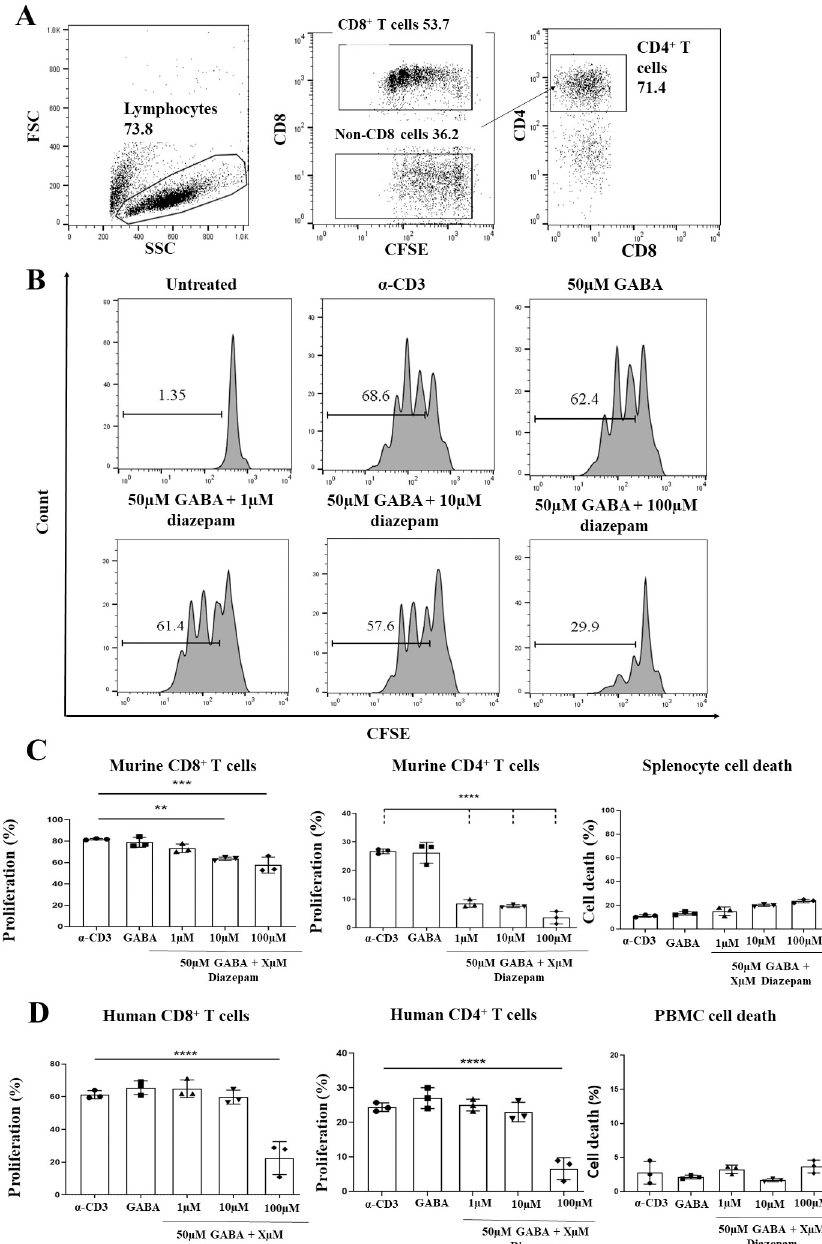
Fig 2. Diazepam can inhibit T cell proliferation in a dose dependent manner. Splenocytes were isolated from the spleens of female wildtype BALB/c mice, and PBMC were isolated from human whole blood samples. Cells were stained with 5 μ M CFSE, before being treated with soluble α -CD3 antibody (33 ng/ml for splenocytes, 100 pg/ml for PBMCs), in addition to 50 μ M GABA alone, or 50 μ M GABA plus 1 μ M, 10 μ M or 100 μ M diazepam. Splenocytes were harvested following 48 hours of treatment, while PBMC were harvested following 96 hours of treatment. The percentage of proliferating T cells in each condition was determined by flow cytometry through assessing the reduction in CFSE fluorescence. A . Representative flow cytometry plots depicting the gating strategy used to identify cell populations of interest from PBMC and splenocyte preparations. Lymphocytes were gated according to size (forward scatter; FSC) and granularity (side scatter; SSC). Within the lymphocyte gate, CD8+ and CD4+ T cells were further gated using established lineage markers for these cells (CD8 and CD4). Histograms were used to determine the percentage of proliferating cells present under each condition, compared to an untreated control. B . Exemplar flow cytometry plots (from human CD8+ T cells) depicting the dose dependent inhibition of α -CD3 stimulated proliferation caused by treatment of cells with 50 μ M GABA and varying concentrations of diazepam. C . Dose